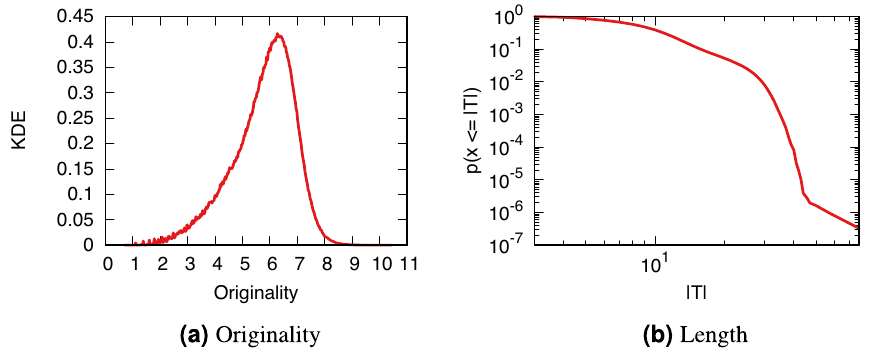
Figure 4. Distributions of O T and | T |. ( a ) Kernel density estimation (KDE) on the y axis of O T values (x axis). ( b ) The probability (y axis) of a post to have a title of length | T | (x axis) or shorter.